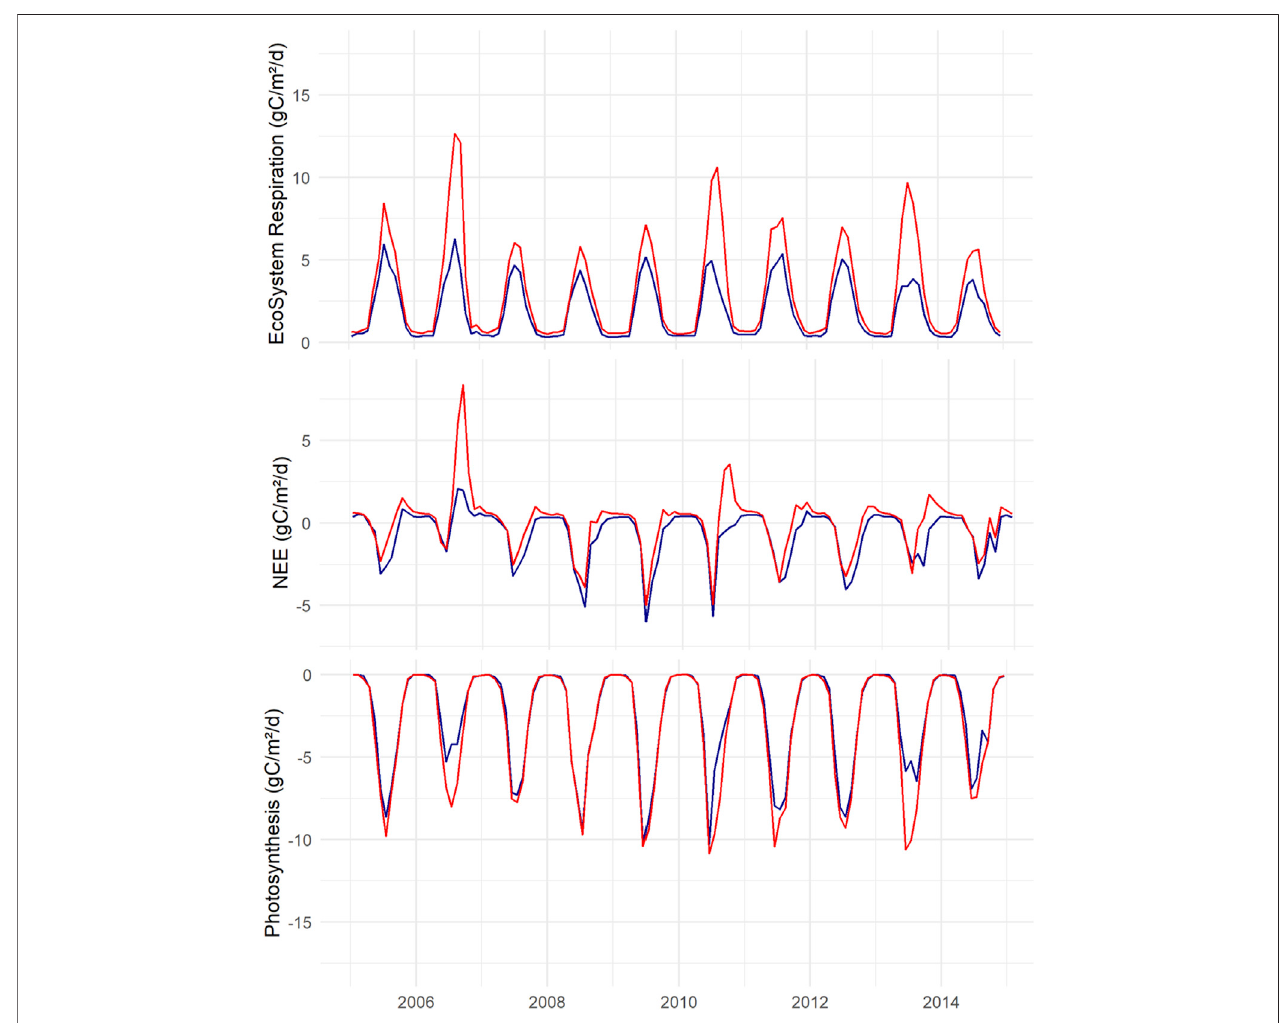
FIGURE 6 | Top, modelled ecosystem respiration (Reco) for K (blue) and L (red). Middle, net ecosystem exchange (NEE). Bottom, gross primary production (GPP). Negative numbers show uptake, monthly averages expressed as g C m − 2 day − 1 .